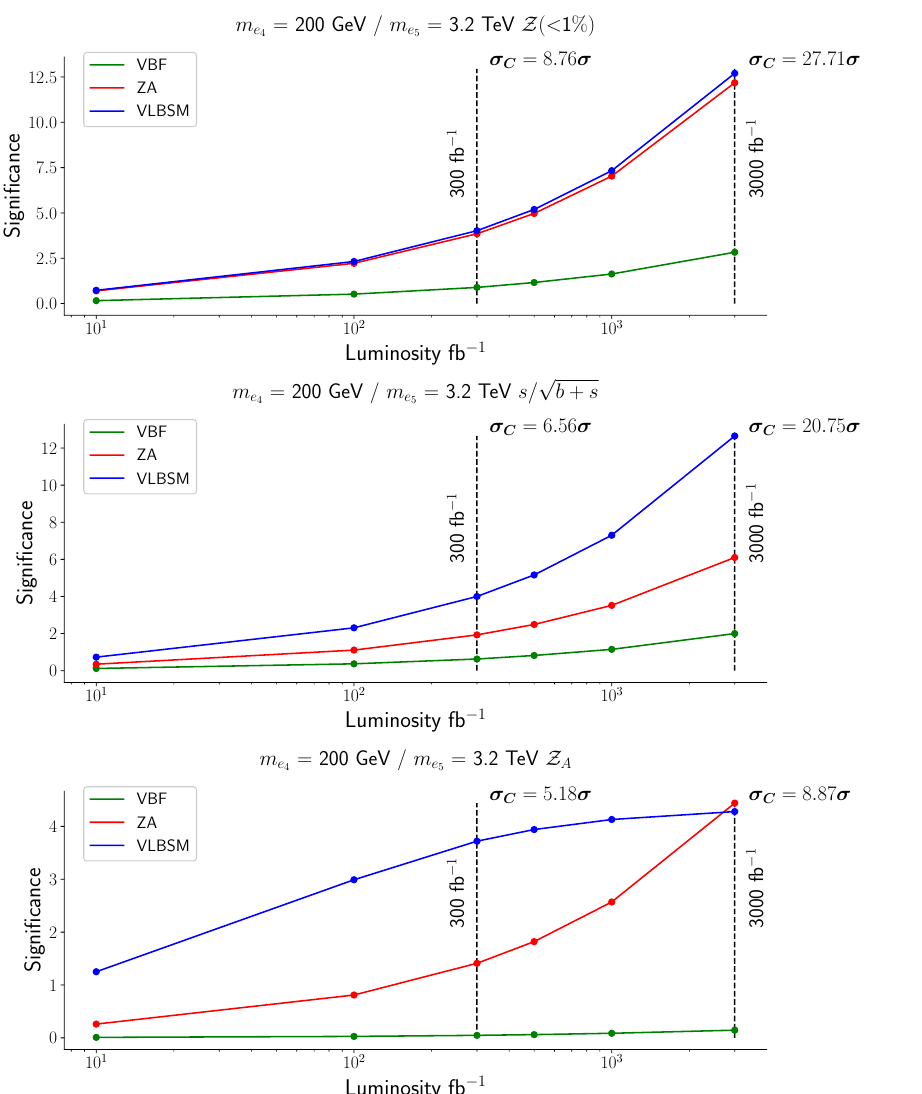
Figure 17. The same as in figure 15 but for an evolutive algorithm that maximizes the Asimov